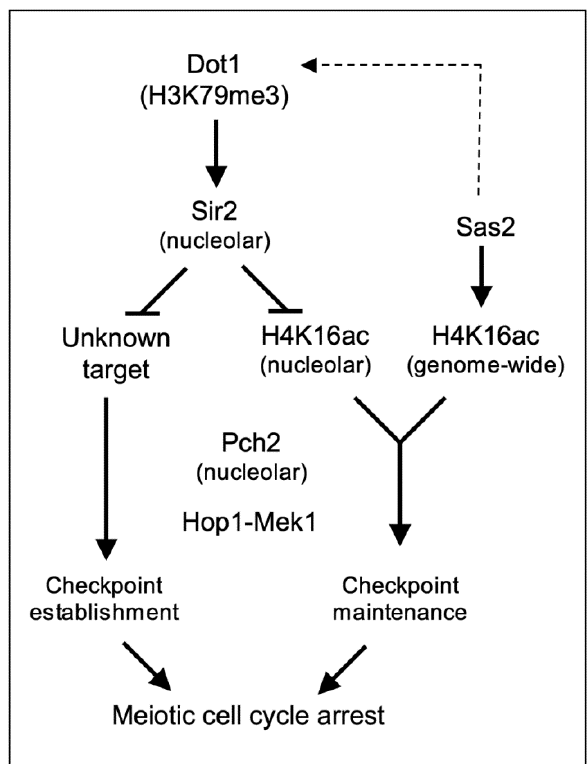
FIGURE 10: A model for the regulation of the meiotic checkpoint by histone post-translational modifications. See text for